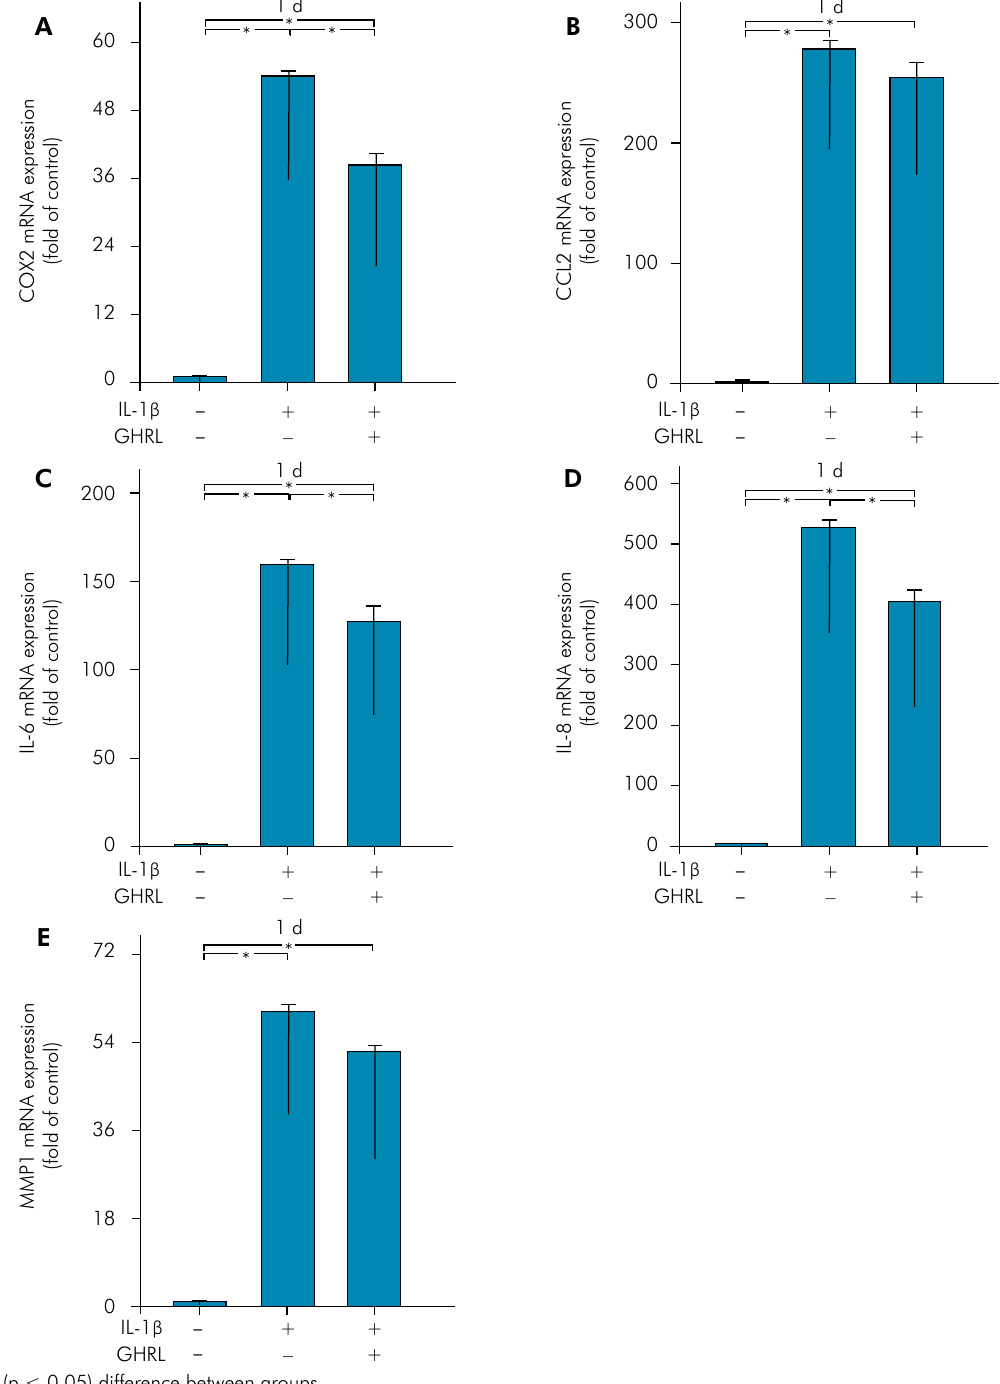
Figure 4. Expression of COX2 (A), CCL2 (B), IL-6 (C), IL-8 (D) and MMP1(E) in response to IL-1 β (1 ng/ml) in the presence and absence of GHRL (20 nM) at 1 d. Untreated cells served as control. Mean ± SEM ( n